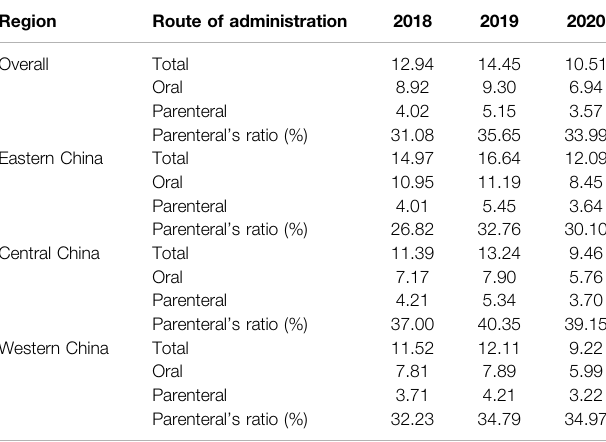
TABLE 2 | Antibiotic consumption in DID in different regions of China from 2018 to 2020. Region Route of